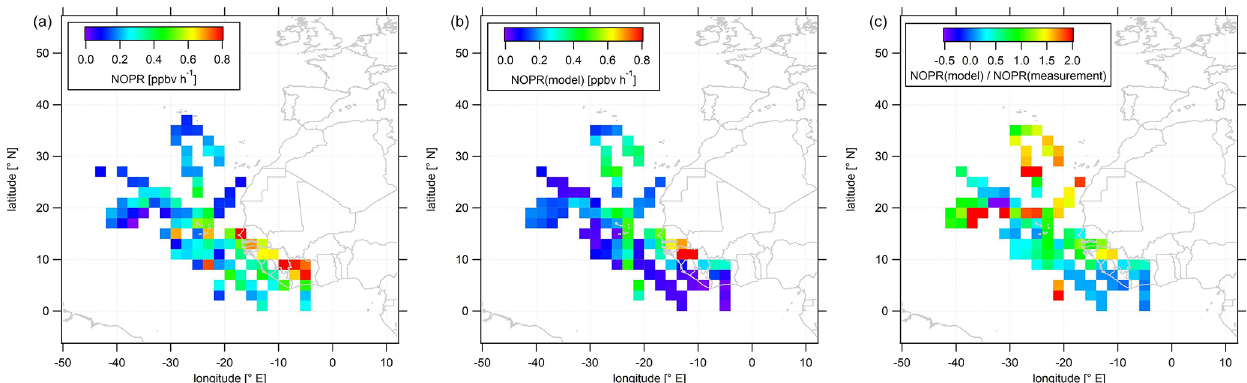
Figure 6. Color-coded spatial, tropospheric distributions of calculated NOPRs above 12km during CAFE-Africa. Panels (a, b) show the spatial distribution of measured and simulated O 3 , respectively. Panel (c) shows the spatial distribution of the NOPR ( model )/ NOPR ( measurement ) ratio. The figures have been filtered for stratospheric measurements by removing data points for which O 3 exceeds